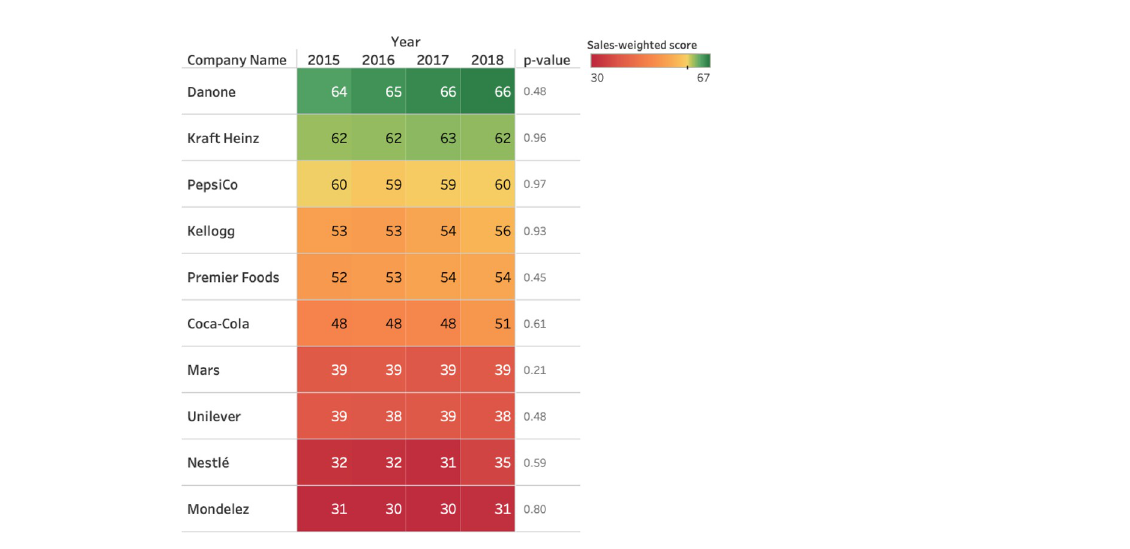
Fig 1. Total sales-weighted nutrient profiling score by company and year.